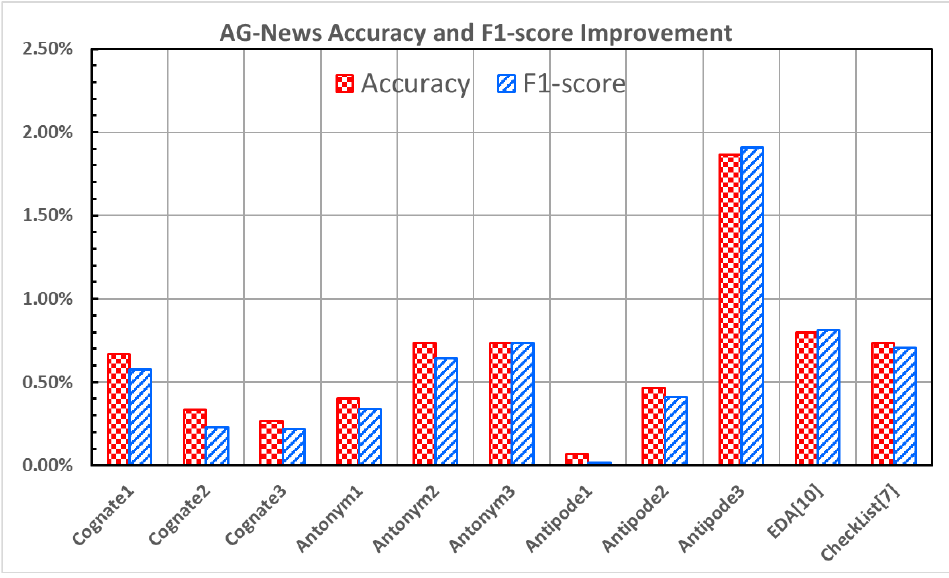
Figure 1. AG-News Performance Improvement Results.